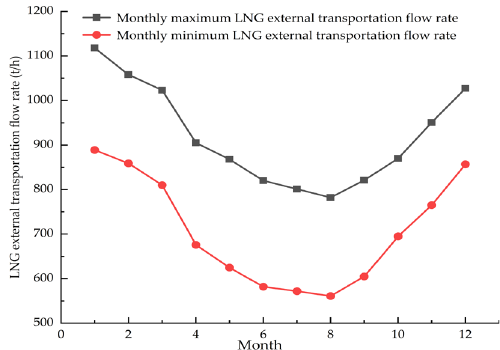
Figure 6. LNG external transportation flow rate of an LNG receiving terminal in 2020.